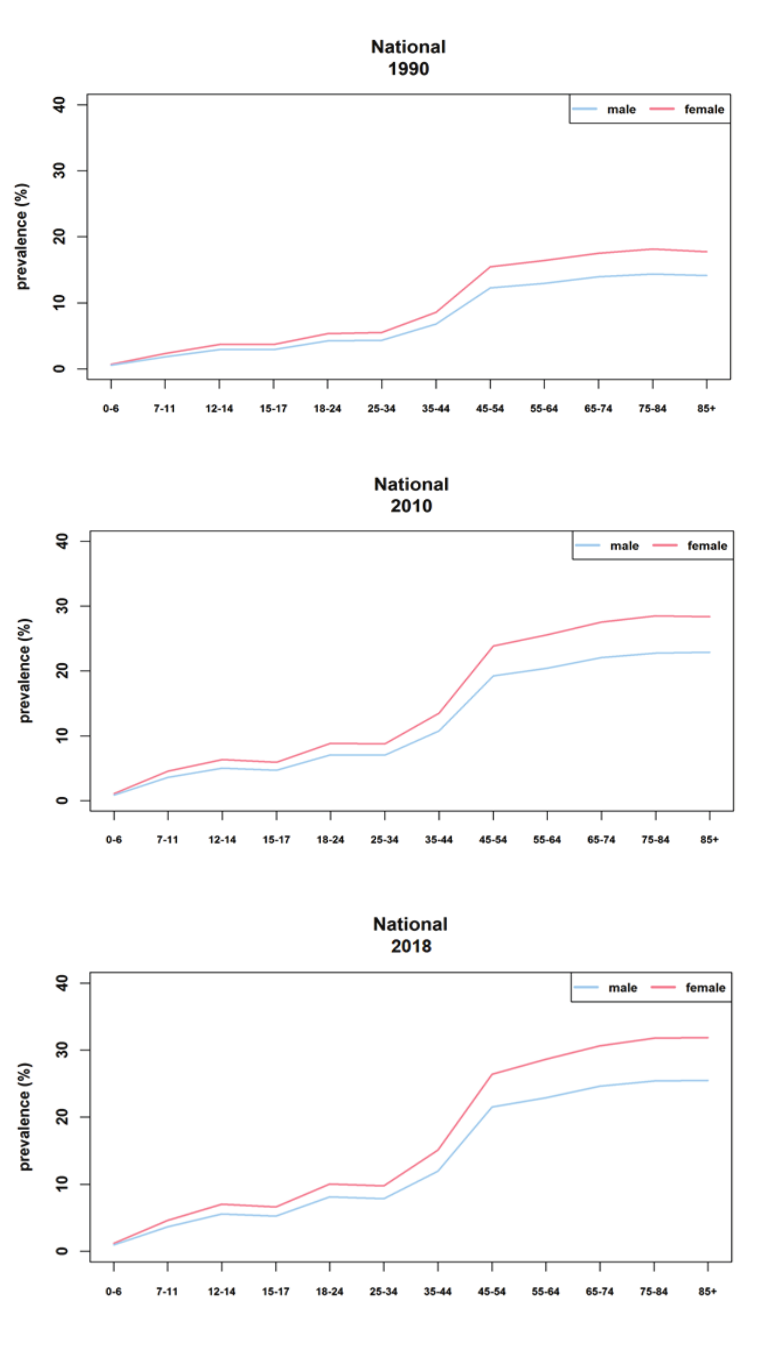
Figure 2. Refractive errors prevalence at national level by sex and age group from 1990 to